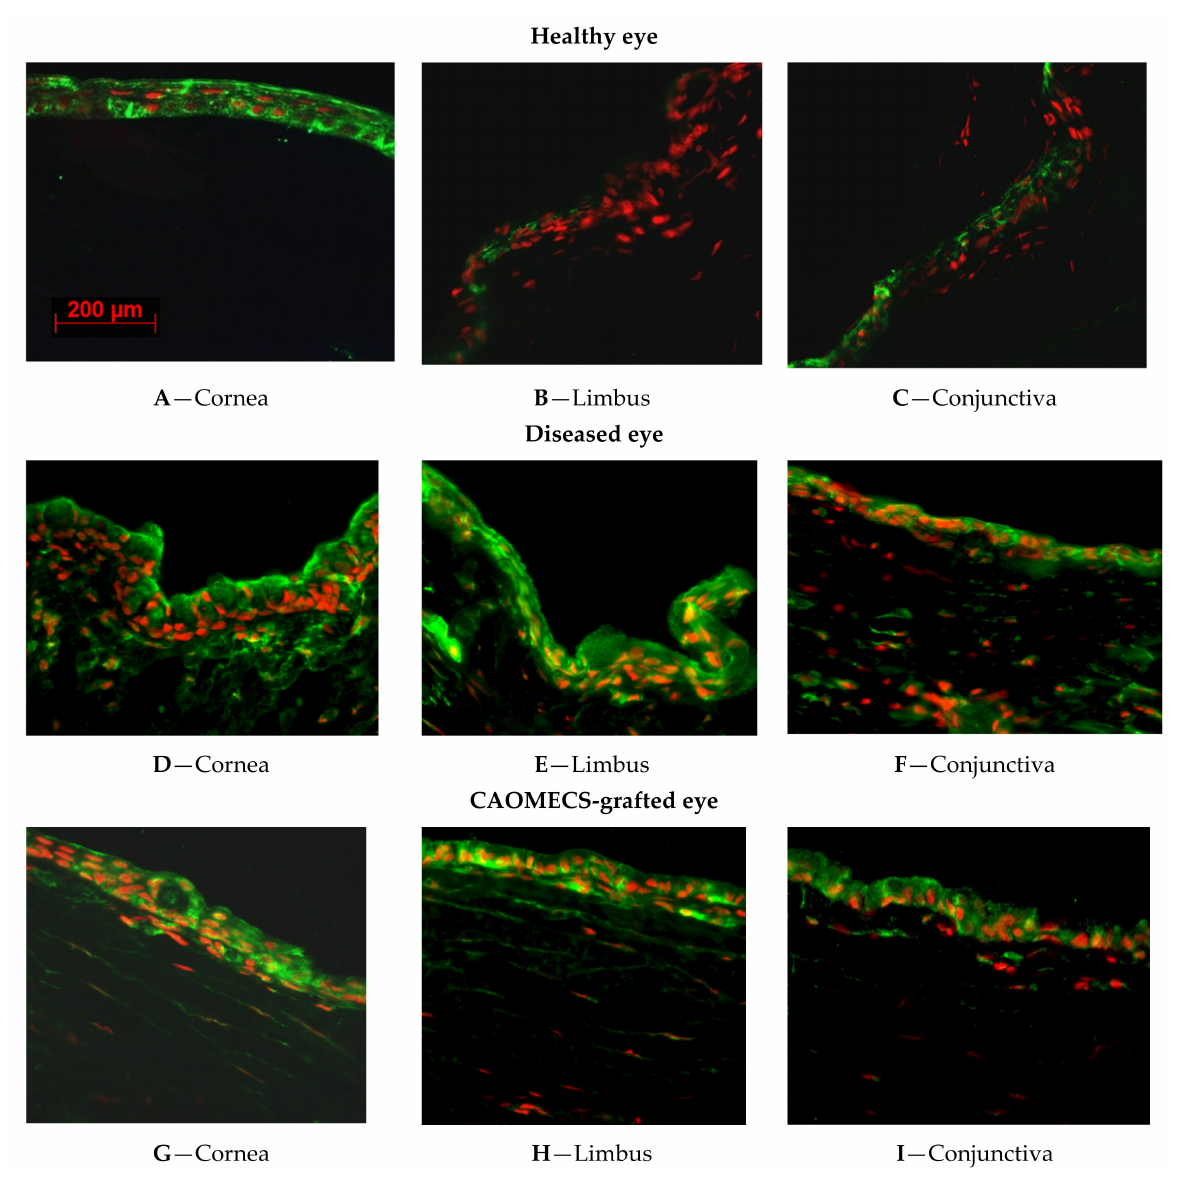
Figure 1. Immunofluorescent staining illustrated the expression pattern of ALDH1A1 in healthy cornea ( A – C ) in LSCD diseased ( D – F ; 9 months after LSCD induction) and CAOMECES grafted ( G – I ) New Zealand white rabbit corneas. ALDH1A1 expression is detected in green, and nuclei are detected in red. The included images are representation of a large sample size. Magnification is 40 ×